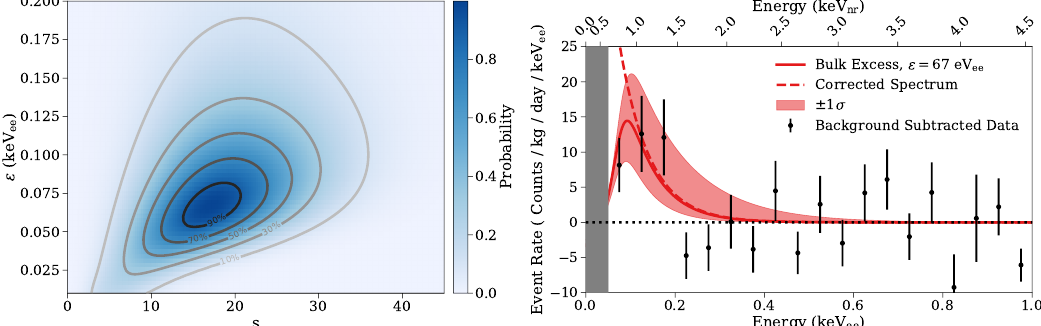
Figure 14: Left: Fit uncertainty in the number of excess signal events over the back- ground model (s) and characteristic decay energy ( ε ) of the generic exponential sig- nal spectrum. The color axis represents the p -value from likelihood-ratio tests to fit results with constrained s and ε . Right: Energy spectrum of the best-fit generic signal (red lines) overlaid on the background-subtracted data (markers). The sub- tracted background model is non-trivial and explained in detail in Ref. [ 67 ] . Both the fit spectrum that includes the detector response (solid line) and the spectrum corrected for the detection efficiency (dashed line) are provided. The ionization ef- ficiency used to construct the equivalent nuclear recoil energy (keV top x-axis is taken from the direct calibration performed in Ref. [ 72 ] . Figures from Ref. [ 67 ]